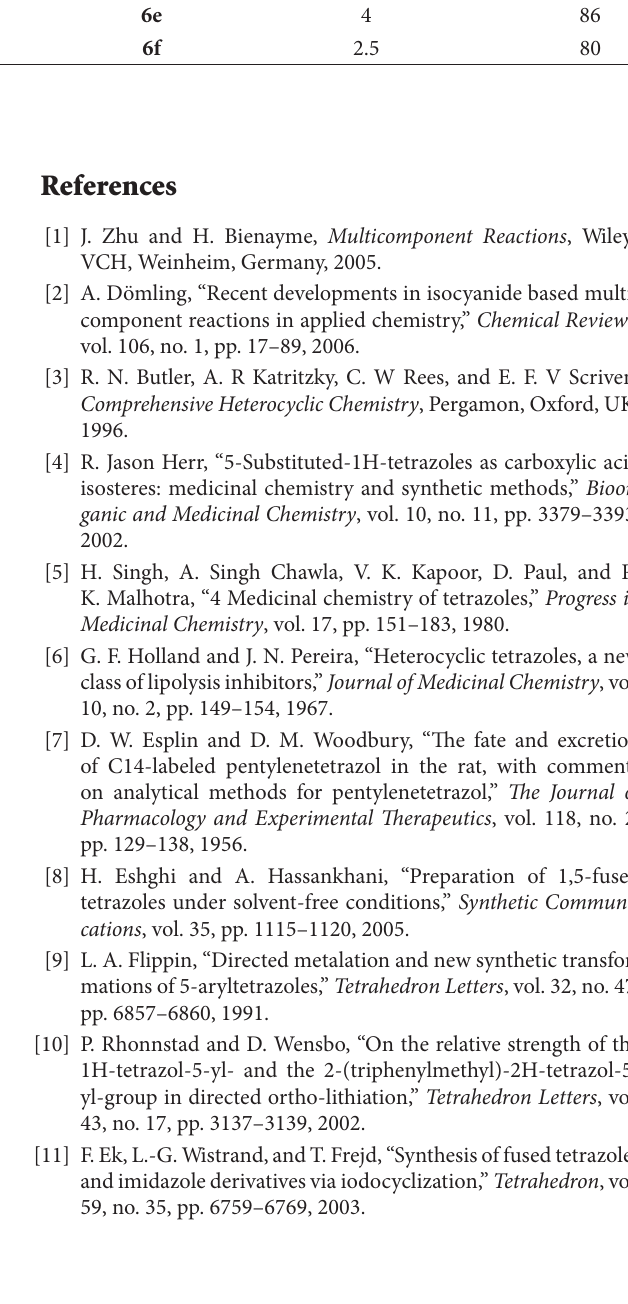
T 3: Synthesis of sulfanyl tetrazoles 4a–f and 6a–f in [Bmim]BF